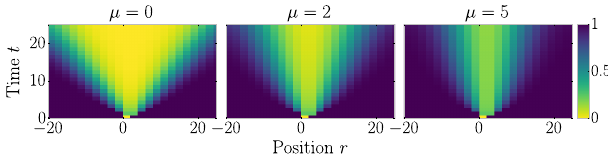
σ þ σ þ r 0 μ for